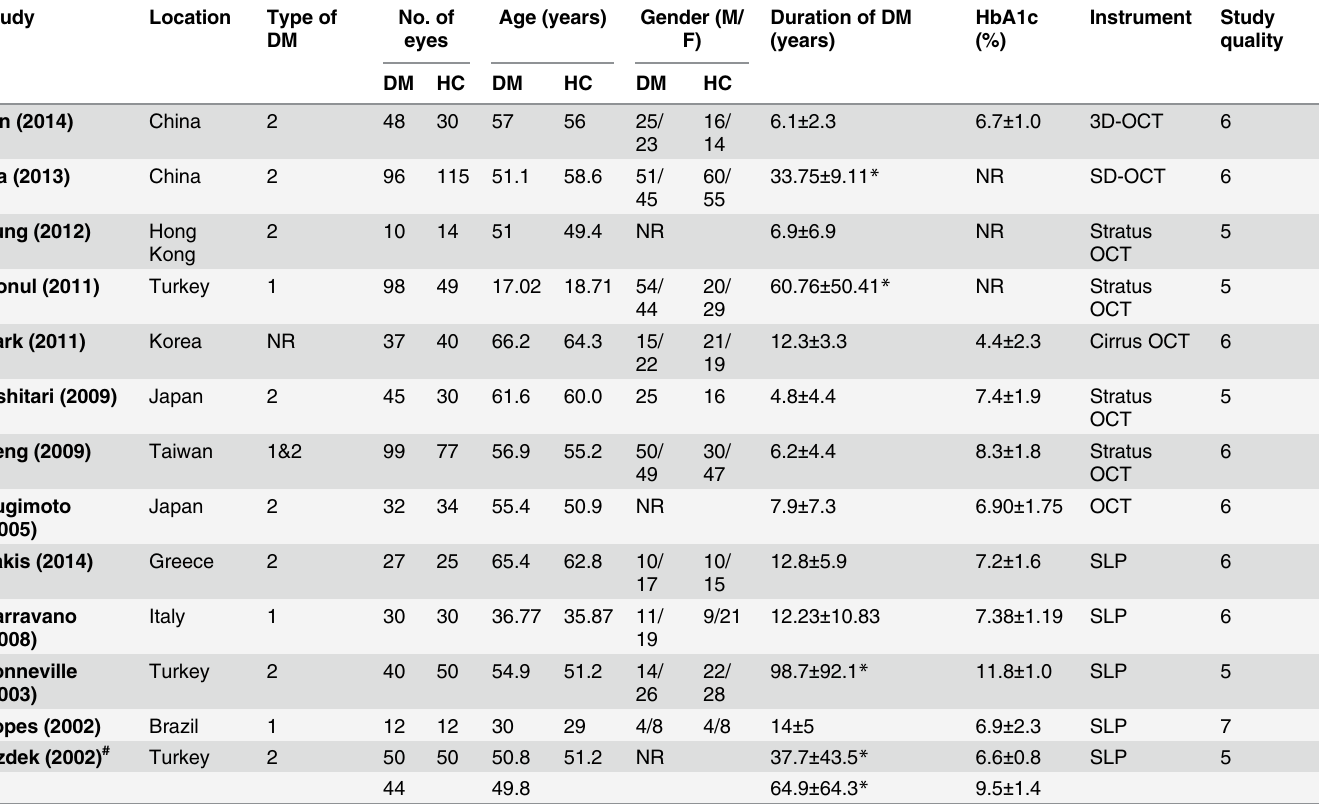
Table 1. Characteristics and quality of selected studies.